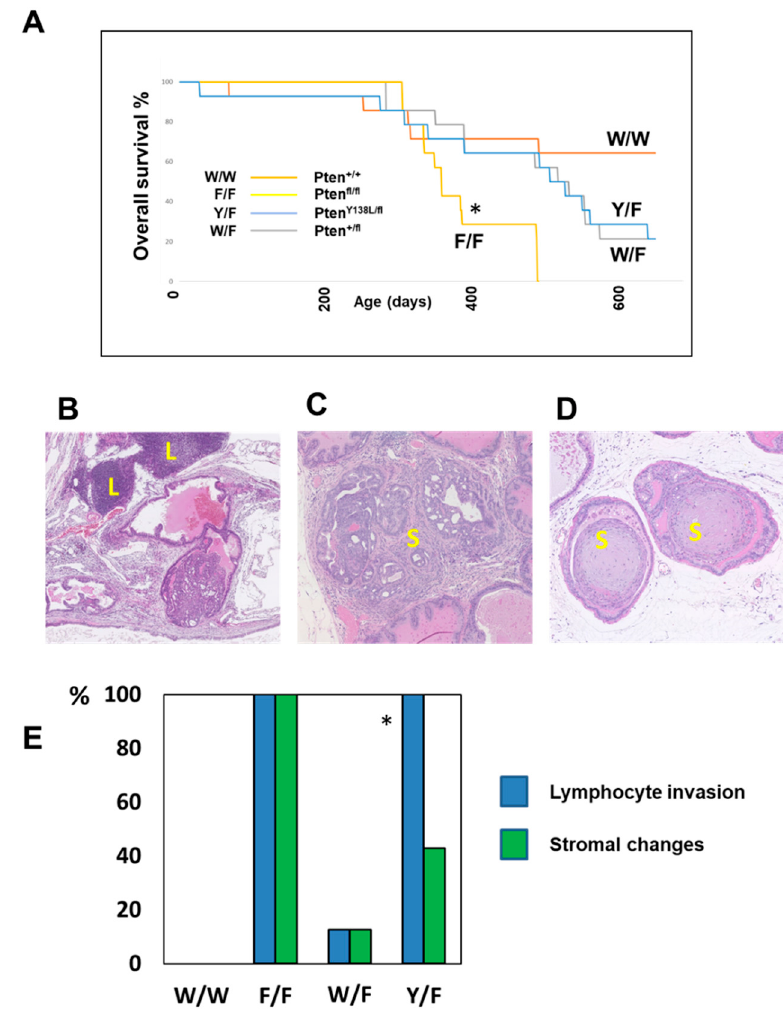
Figure 4. ( A ) Overall survival of cohorts of the indicated Pten genotype mice is shown. * Statistical analysis by Log Rank (Mantel Cox) test show a significant difference in survival ( p < 0.05) between WW vs. FF groups. ( B – D ) Sections of H&E (hematoxylin and eosin) stained prostate tissues from F/F mice at 20 weeks of age which illustrate the lymphocyte invasion (L) and stromal changes (S) observed in many of the mice. ( E ) The observation of these changes in each prostate at 20 weeks of age is noted for each genotype. N = 6 per genotype. W/W = Pten + / + ; W/F = Pten + / flox ; Y/F = Pten Y138L / flox ; F/F = Pten flox / flox . * 8/8 Y/F mice displayed lymphocyte infiltration, significantly different from the W/F cohort which showed only 1 mouse with lymphocyte infiltration ( p < 0.005 Fisher’s exact test).